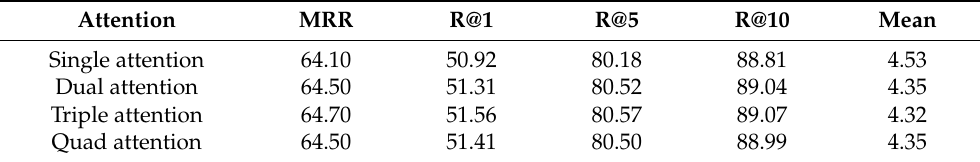
Table 2. Analysis of the attention effects of the Find module. MRR, mean reciprocal rank.